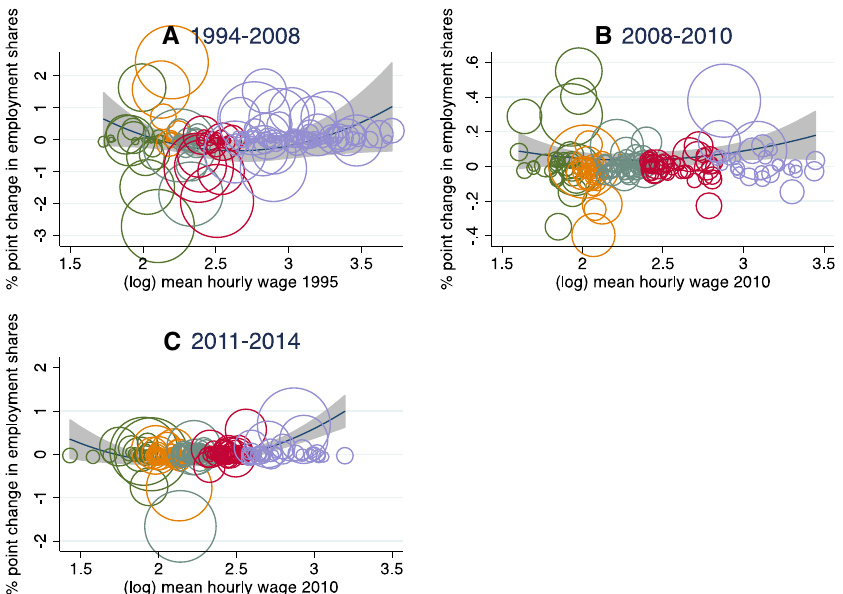
Fig. 4 Employment shares growth in Spain by mean hourly wage in three different periods: 1994–2008, 2008–2010,and 2010–2014. Notes scatter plot and quadratic prediction curve.The dimension of each circle corresponds to the number of observations within each occupation in 1994 ( a ), in 2008 ( b ), and in 2011 ( c ); the grey area shows 95% confidence interval. Employment shares are measured in terms of workers. Colours represent the quintile of each job (green, first quintile; yellow, second quintile, grey, third quintile; red, fourth quintile; and violet, fifth quintile). Sources author’s analysis from the Spanish Labour Force Survey (1994, 2008, 2011, 2014), and the Structure of Earnings Survey (1995, 2010) (color figure